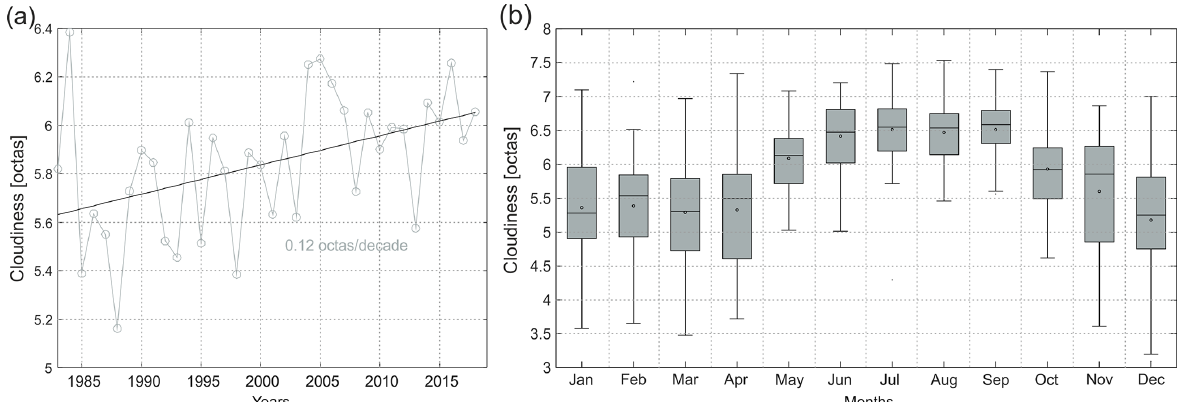
Figure 9. (a) Variability of mean annual cloudiness in 1983–2018 at Hornsund. (b) Variability of the monthly sums of cloudiness at Hornsund in the period 1983–2018.